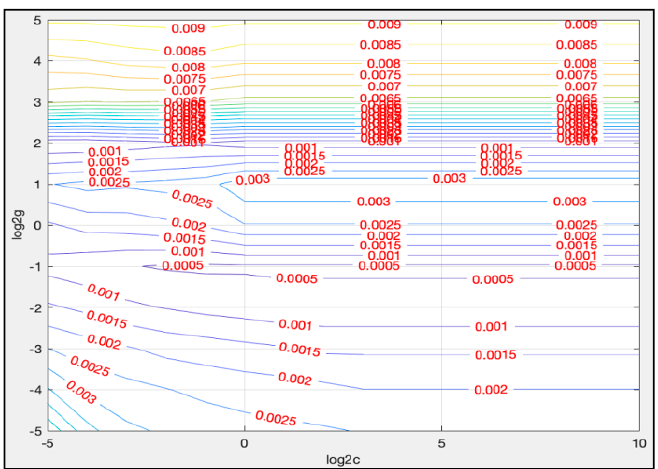
Figure 9. Result of coarse selection.